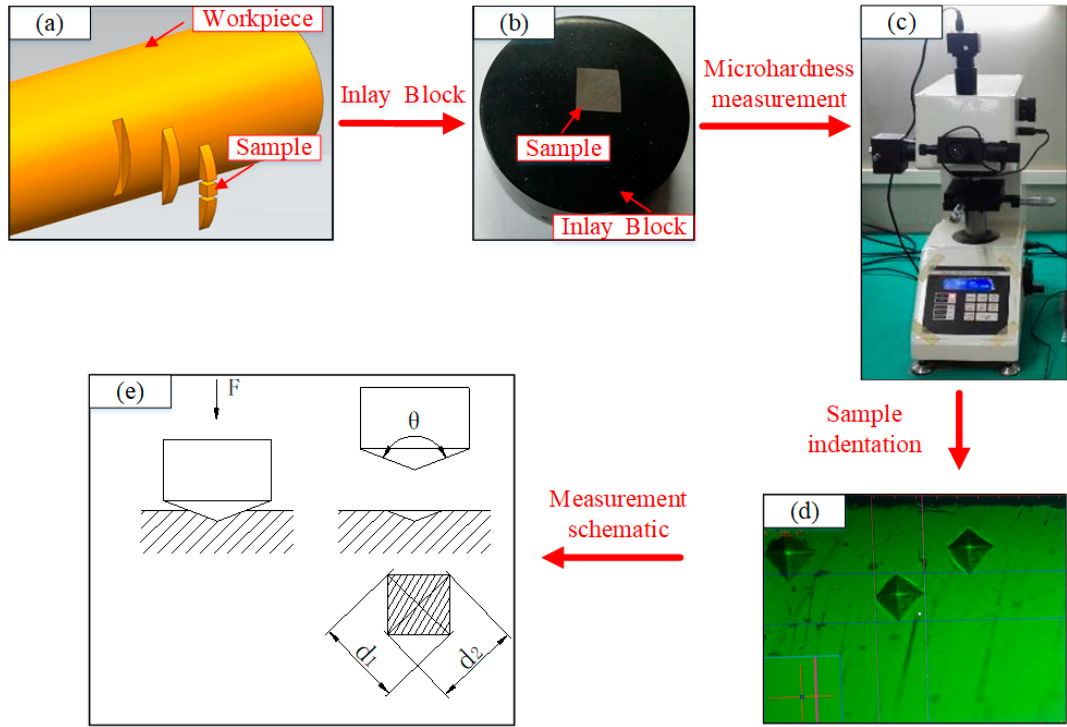
Figure 4. Microhardness measurement process and relevant samples: ( a ) sampling schematic; ( b ) inlay sample; ( c ) microhardness tester; ( d ) sample indentation; ( e ) measurement schematic.